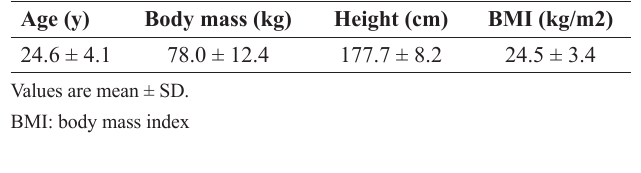
Table 1. Physical characteristics of the subjects ( N =